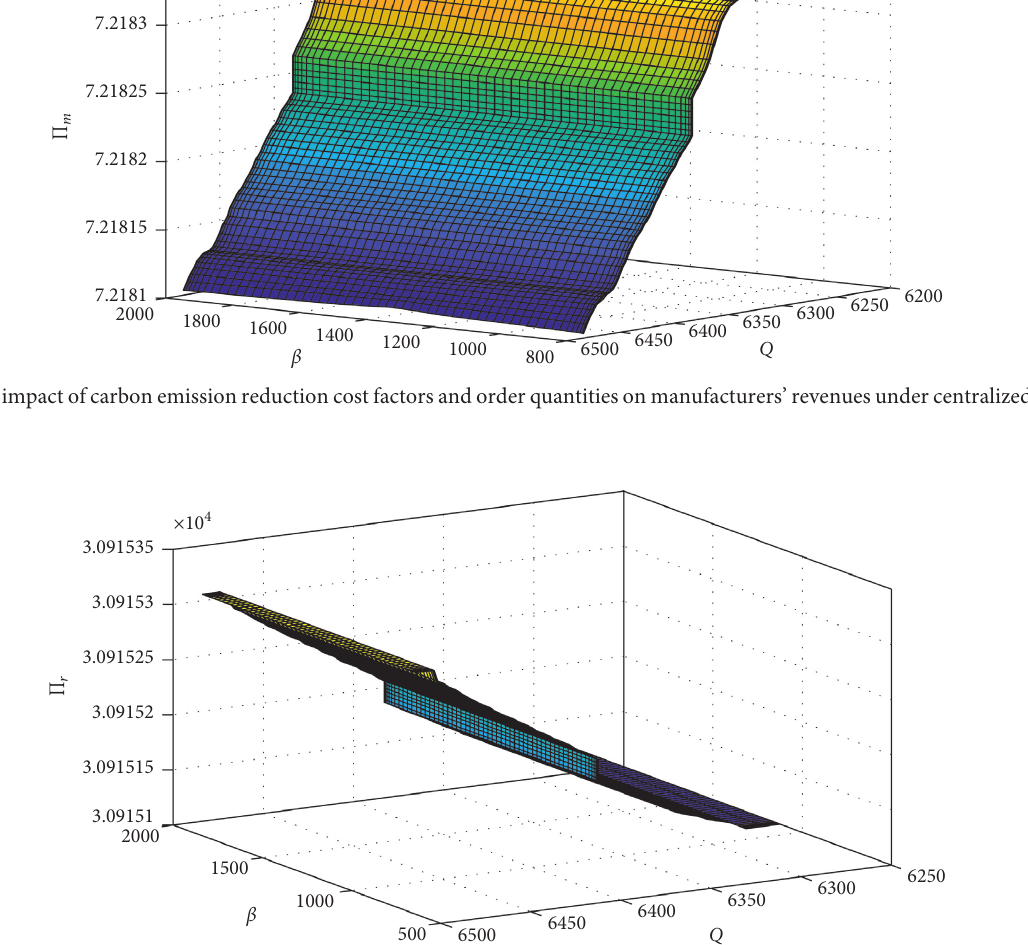
Figure 5: The impact of carbon emission reduction cost factors and order quantities on retailer revenue under centralized decision-making.